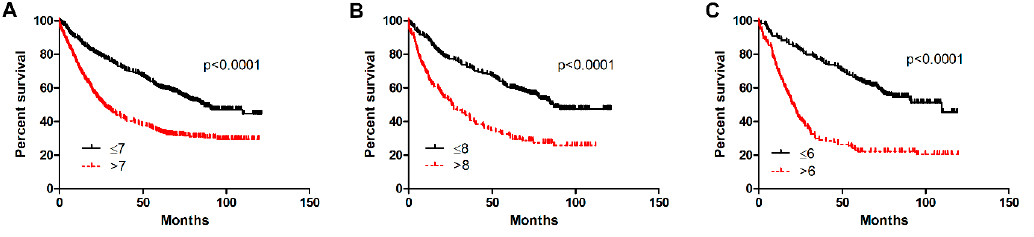
Figure 8. Kaplan–Meier survival curves reflecting the prognostic impact of periostin (POSTN) expression by cancer-associated fibroblasts (CAFs) on overall survival (OS) of patients with non-small cell lung cancer (NSCLC). The prognostic impact of periostin (POSTN) expression levels (immunohistochemistry, IHC) was studied in ( A ) the whole patient cohort (**** p < 0.0001) and in individual histological types, i.e., ( B ) squamous cell cancer (SCC) (**** p < 0.0001) and ( C ) adenocarcinoma (AC) (**** p < 0.0001); Mann–Whitney U test. Cut-off points for the analysis were estimated based on the median.